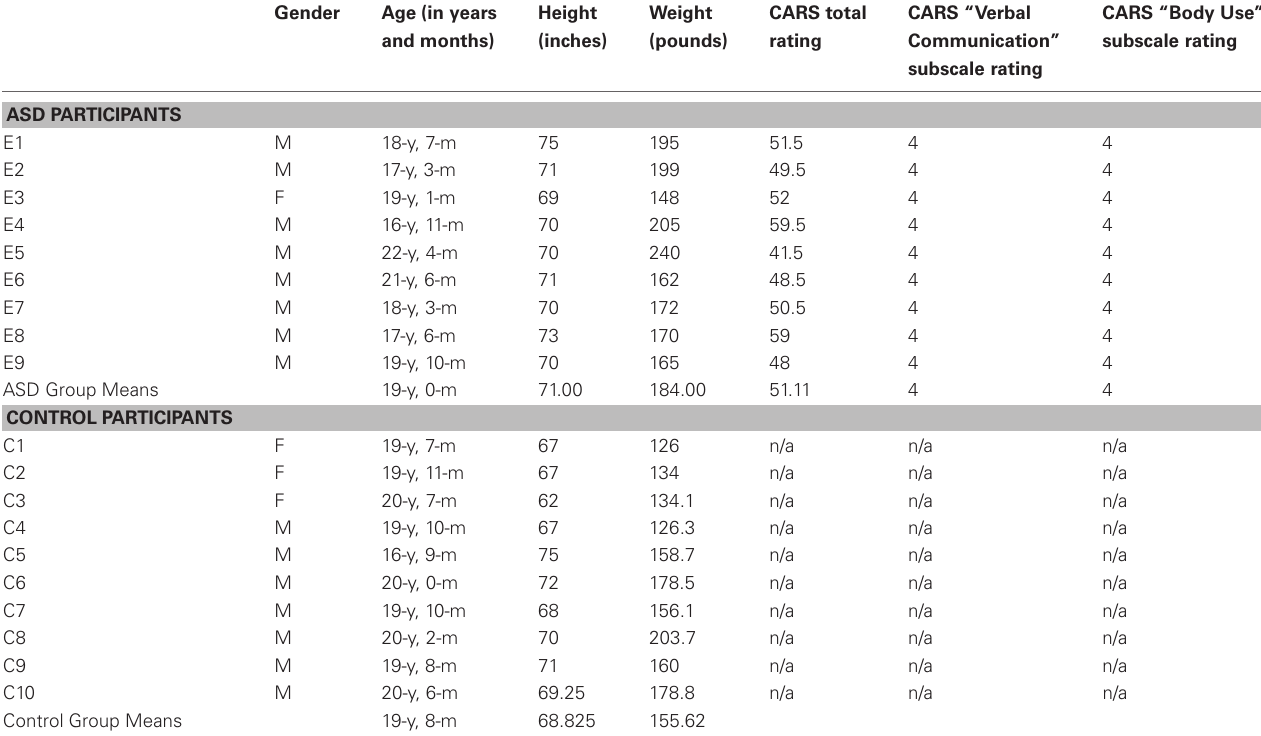
Table 1 | Participants. Gender CARS